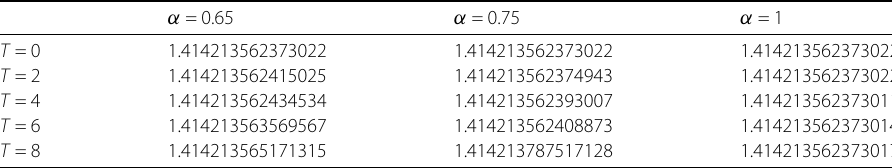
Table 3 The values of Q n u at different T for α = 0.65, 0.75, and 1 with τ = h = 0.1 α = 0.65 α = 0.75 α = 1 T = 0